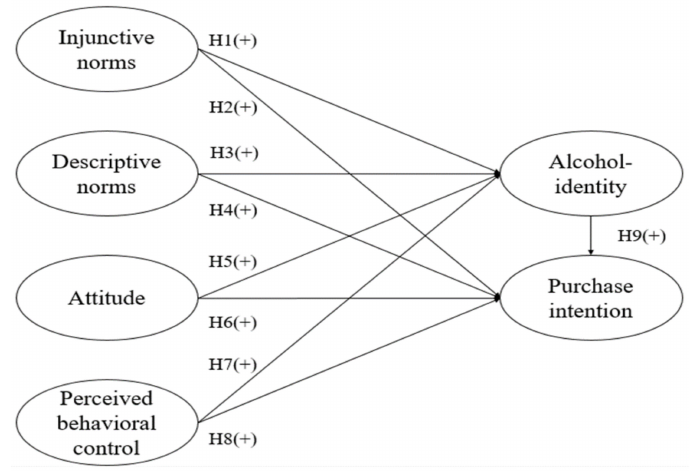
Figure 1. Conceptual